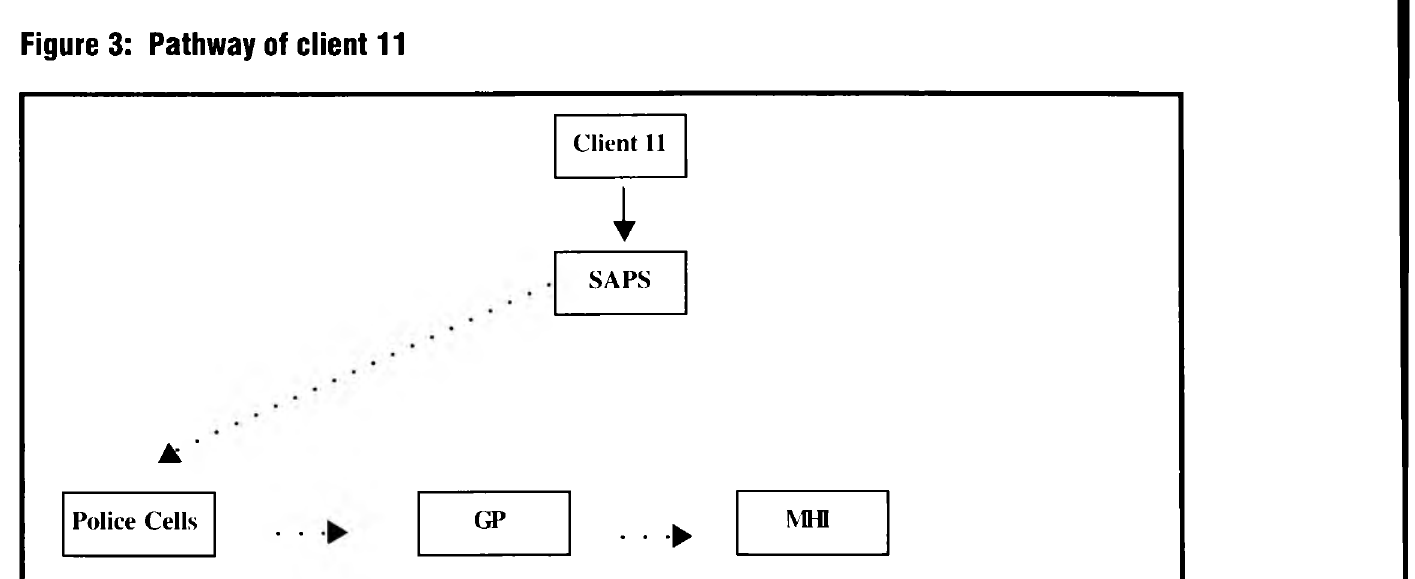
Figure 3: Pathway of client 11